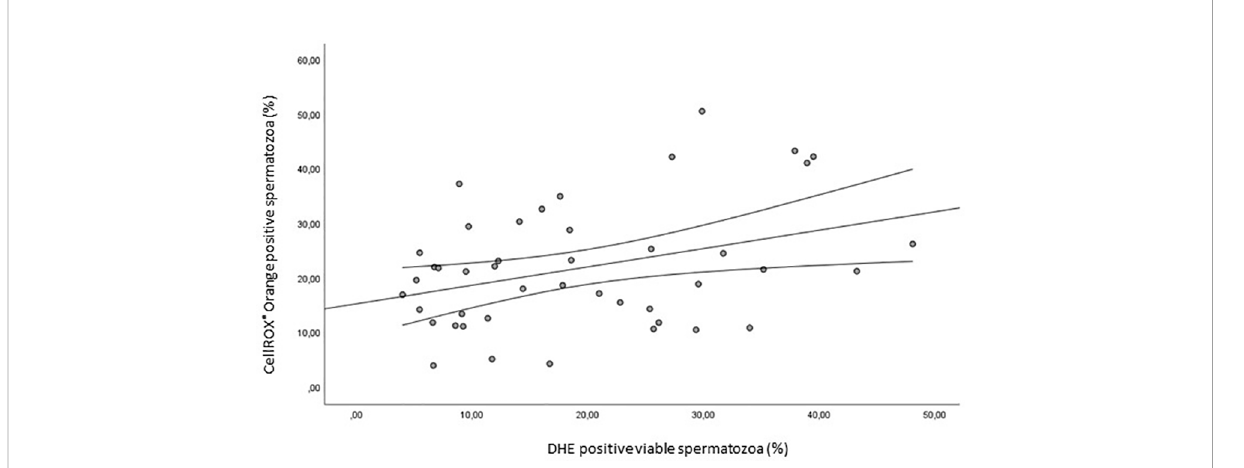
FIGURE 12 Scatter plot representing the relationships between the percentage of CellROX ® Orange positive spermatozoa and the percentage of DHE positive viable spermatozoa (R=0.4, p<0.05,